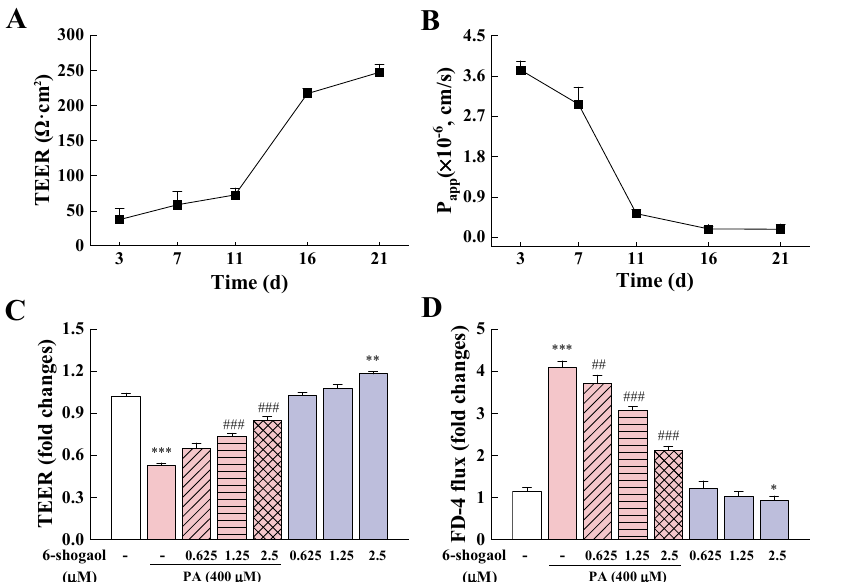
Figure 2. 6-Shogaol alleviated PA-induced intestinal epithelial barrier dysfunction in Caco-2 cells: ( A ) Changes in transepithelial electrical resistance (TEER) during Caco-2 cell modeling; ( B ) FD-4 flux changes during Caco-2 cell modeling; ( C ) Effects of 6-shogaol on TEER in PA-treated Caco-2 monolayers; ( D ) Effects of 6-shogaol on the permeability of PA-treated Caco-2 monolayers. Data are given as means ± standard deviations (n = 3). * p < 0.05, ** p < 0.01, *** p < 0.001 vs. the control; ## p < 0.01, ### p < 0.001 vs. the PA-treated group.